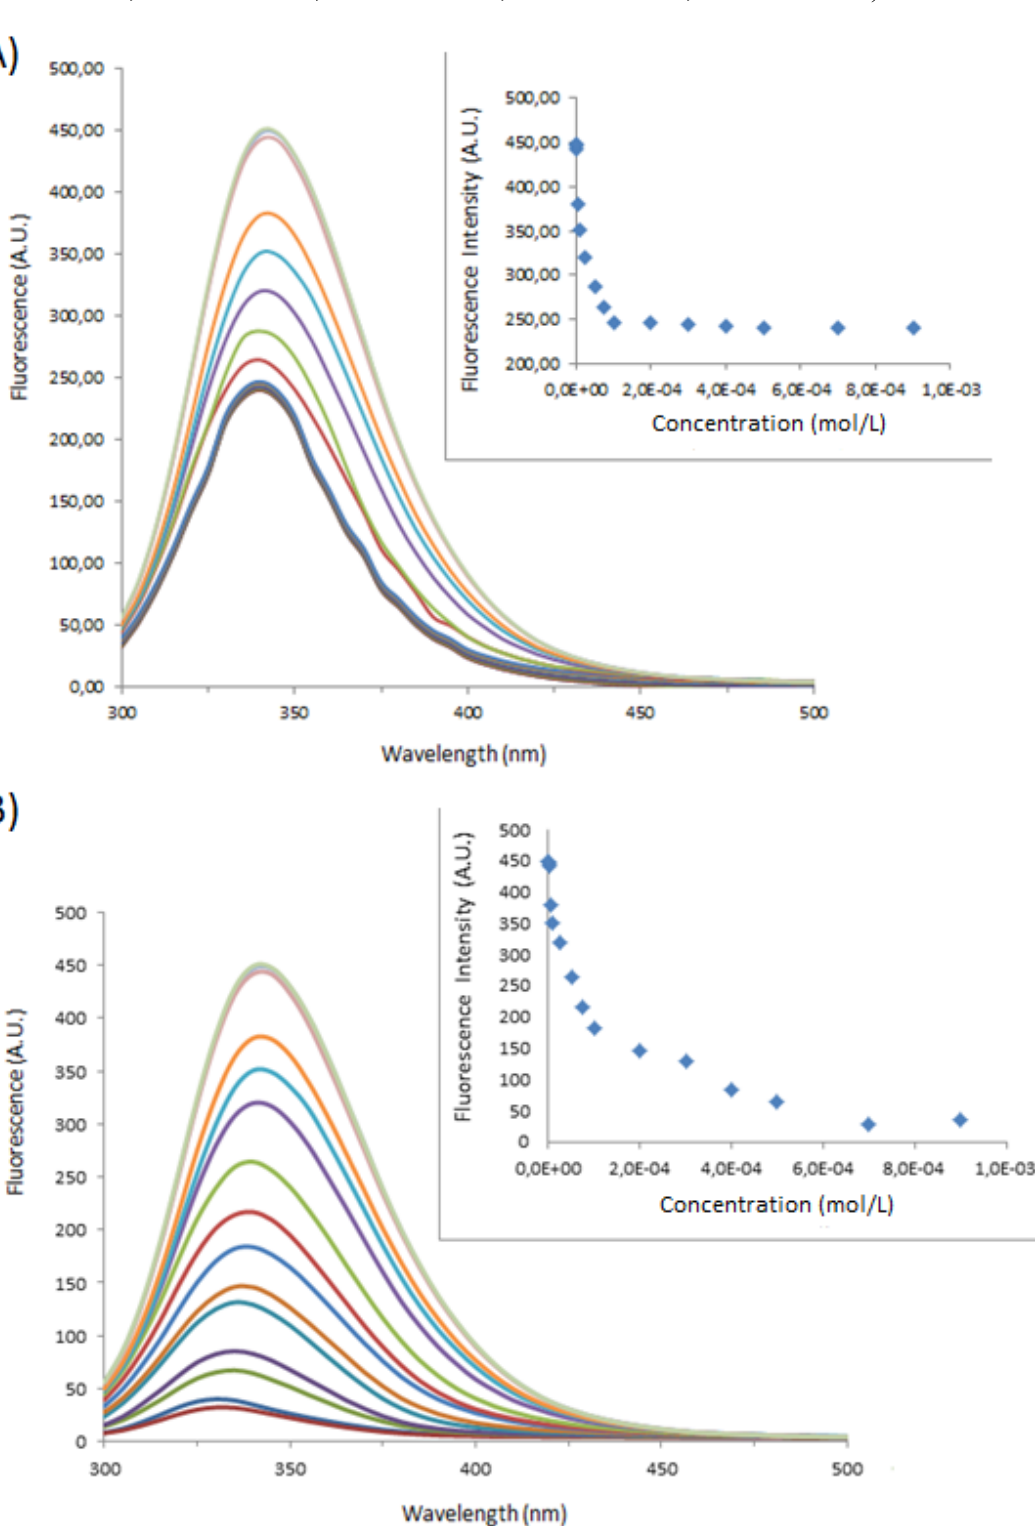
Figure 2. Fluorescence spectra of BSA at 1 × 10 − 5 M with varying concentrations of ( A ) 1 or ( B ) 1 _Ag_NP. In the inset, BSA maximum fluorescence intensity as a function of ( A ) 1 or ( B ) 1 _Ag_NP. (— DI Water; — 1 × 10 − 6 M; — 2.5 × 10 − 6 M; — 5 × 10 − 6 M; — 1 × 10 − 5 M; — 2.5 × 10 − 4 M; — 5 × 10 − 5 M; — 7.5 × 10 − 5 M; — 1 × 10 − 4 M; — 2 × 10 − 4 M; — 3 × 10 − 4 M; — 4 × 10 − 4 M; — 5 × 10 − 4 M; — 7 × 10 − 4 M; — 9 × 10 − 4